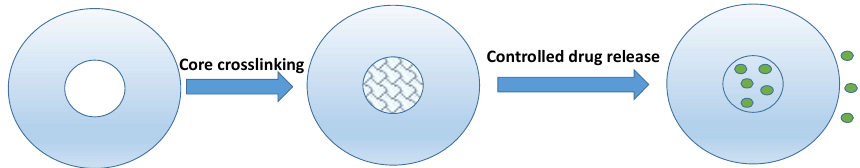
Figure 4. Illustration of core-crosslinked nanoconjugate for controlled drug release [92]. The green dots represent the drug molecules.